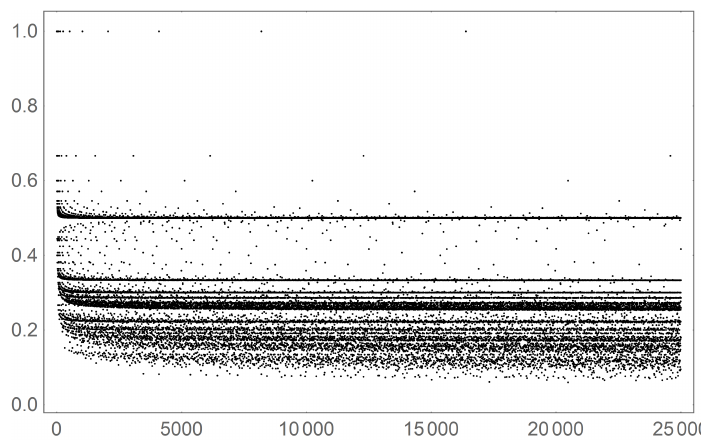
Figure 10. Saturation values for the first 25,000 integer values of p . Visible striations appear because of the asymptotic “attractor” values of for number whose prime decomposition consist of high